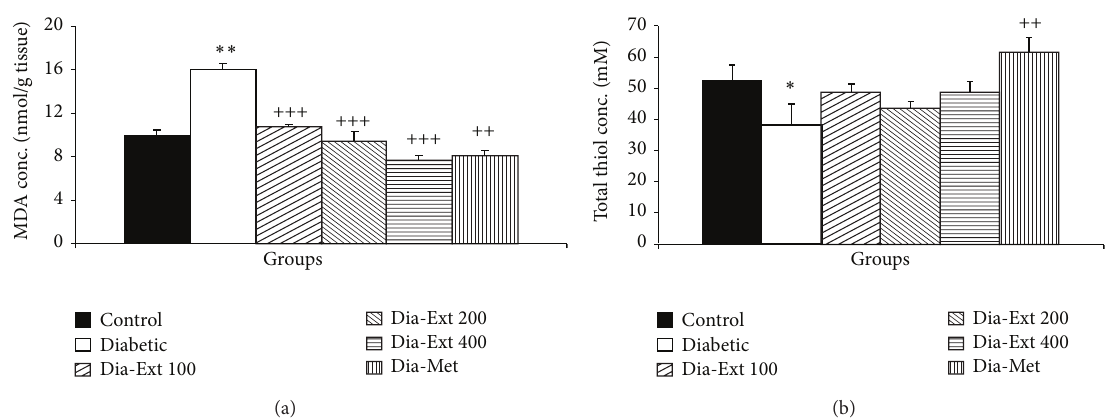
Figure 4: The MDA concentrations (a) and total thiol concentrations (b) in hippocampal tissues of 6 groups. Data are shown as mean ± SEM of 10 animals per group. ∗ 𝑃 < 0.05 and ∗∗∗ 𝑃 < 0.001 in comparison with Control group and ++ 𝑃 < 0.01 and +++ 𝑃 < 0.001 in comparison with Diabetic group.